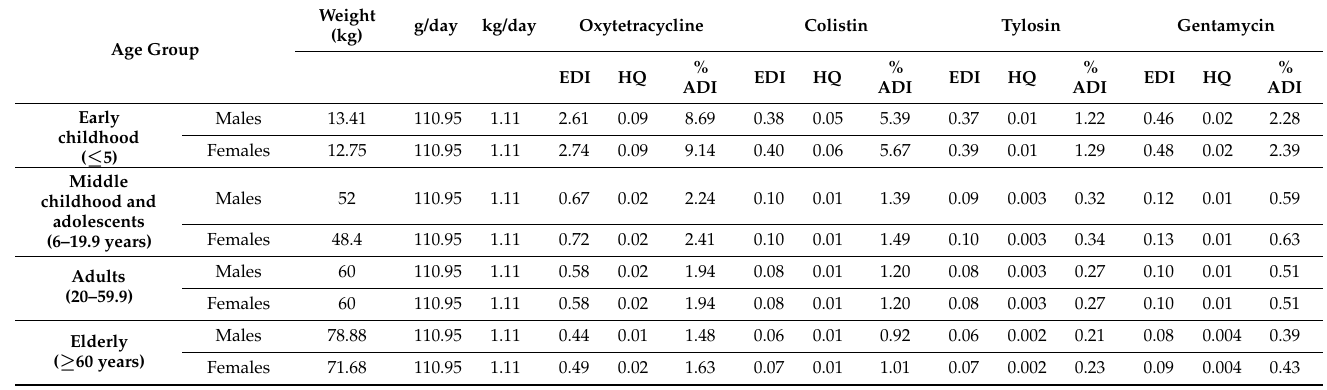
Table 6. Risk characterization of dietary exposure to antibiotic residues through consumption of milk among various age groups using the deterministic